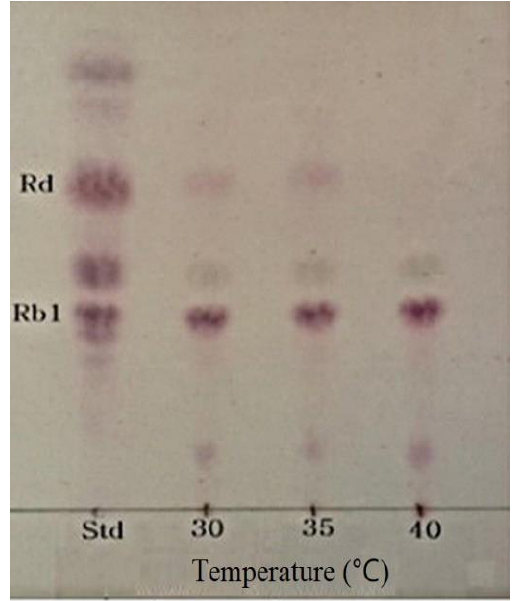
Figure 5. TLC analysis of ginsenoside Rb1 hydrolyzed by crude enzyme of isolated strain URN103L at different temperatures (30, 35, and 40 °C) at pH 7.0 for 7 days.